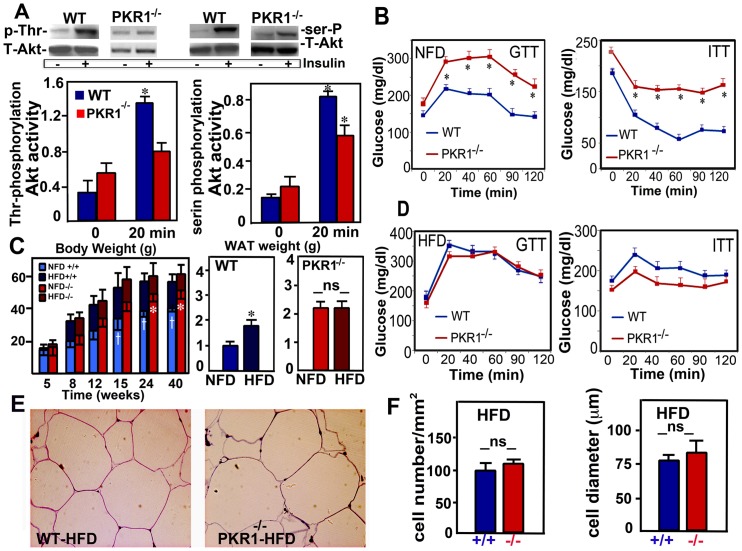
PKR1 null mutant mice exhibit a diabetes-like syndrome.A) Western blot analyses on lysates derived from the adipose tissue of both group of mice 0 or 20 min after i.p. 0.75U/I insulin injections. Western blot analyses revealed that insulin-stimulated phosphorylation of Akt (at serine and threonine) were significantly lower in PKR1−/− adipose tissue as compare to wild (WT) adipose tissue (* p<0.05, n = 3). B) Glucose tolerance (GTT) and Insulin tolerance tests (ITT) in 40 weeks old mice. PKR1−/− mice did not tolerate glucose load and displayed impaired ITT (* p<0.05, n = 8). C) Body weight increases in HFD-fed and NFD-fed mice. * shows a significant difference between NFD-fed PKR1−/− mice and WT mice, n = 8. t shows difference between HFD-fed and NFD-fed WT mice (blue). D) GTT and ITT in HFD-fed mice at the age of 40 weeks. No significant alteration was observed between the groups, due to severe increase in GTT and ITT of WT mice treated with HFD (* p<0.05, n = 8). E) Representative illustration of semi-thin sections of adipocyte tissue derived from PKR1−/− and WT mice after HFD feeding showing the hypertrophic adipocytes in both groups (×40). F) Histogram shows cell numbers and diameters are similar between these two groups of mice (ns = no significance, p>0.05, n = 20).